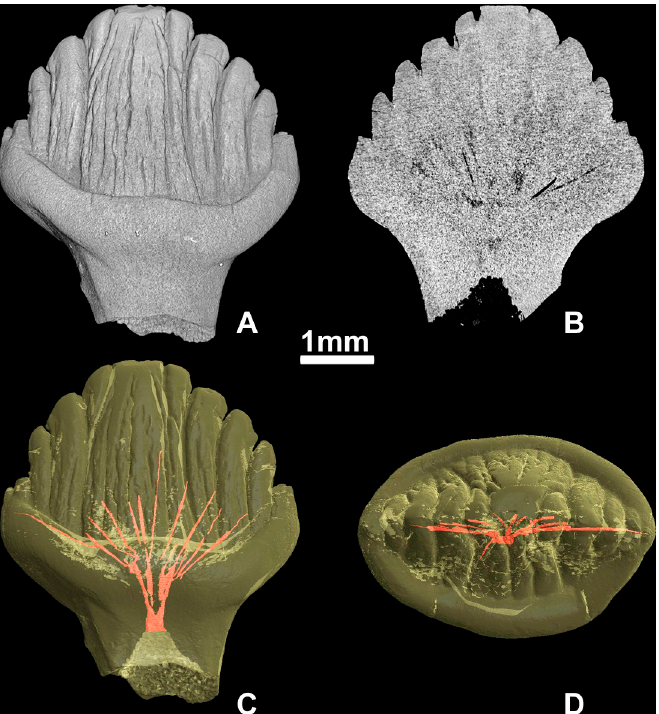
Fig 12. Tooth microanatomy of Stegosauria indet. from the Teete locality, Yakutia, Russia; Batylykh Formation (Lower Cretaceous). Digital restorations of the unworn tooth ZIN PH 65/246 in lingual view (A), vertical cross- section (B), in lingual view with visualized pulp cavity and diverging canals (C) and in occlusal view with visualized pulp and diverging canals (D).